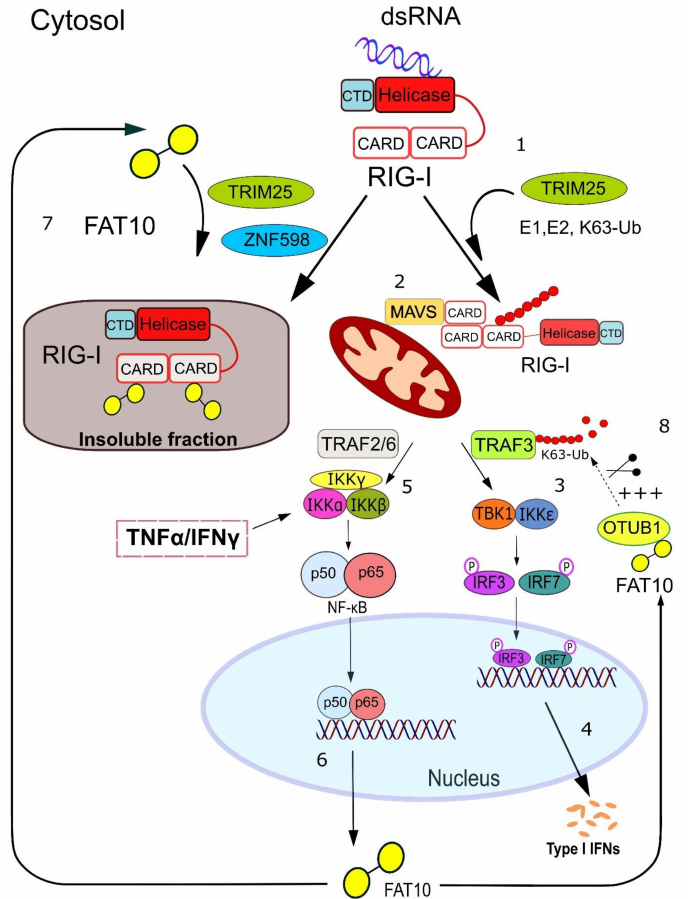
Figure 6. Proposed model of FAT10-mediated regulation of type-I interferon response. 1 . RIG-I undergoes activating conformational changes and ubiquitylation upon binding to viral